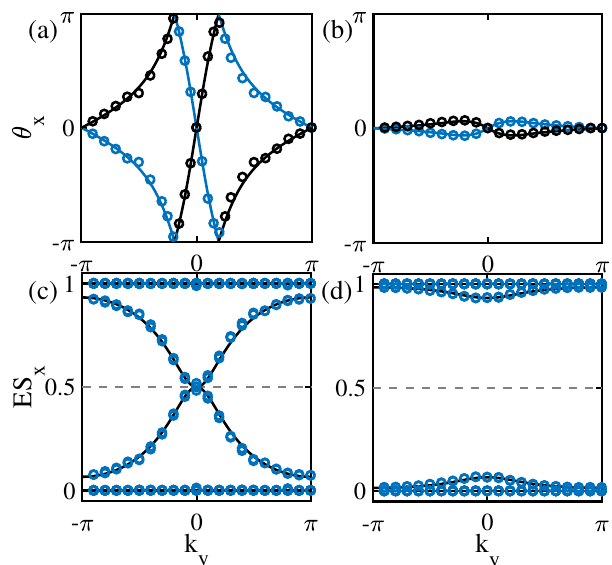
Fig. 3 Observation of Wilson loop spectra and entanglement spectra. a , b The experimentally measured Wilson loop spectra (solid circles) in comparison with the numerically calculated ones (solid lines). c , d The experimentally measured entanglement spectra (circles) in comparison with the numerical ones (solid lines). We consider the nontrivial Euler Hamiltonian H ( k ) in Eq. (1) with m = 1 in a , c and the trivial one with m = 3 in b , d